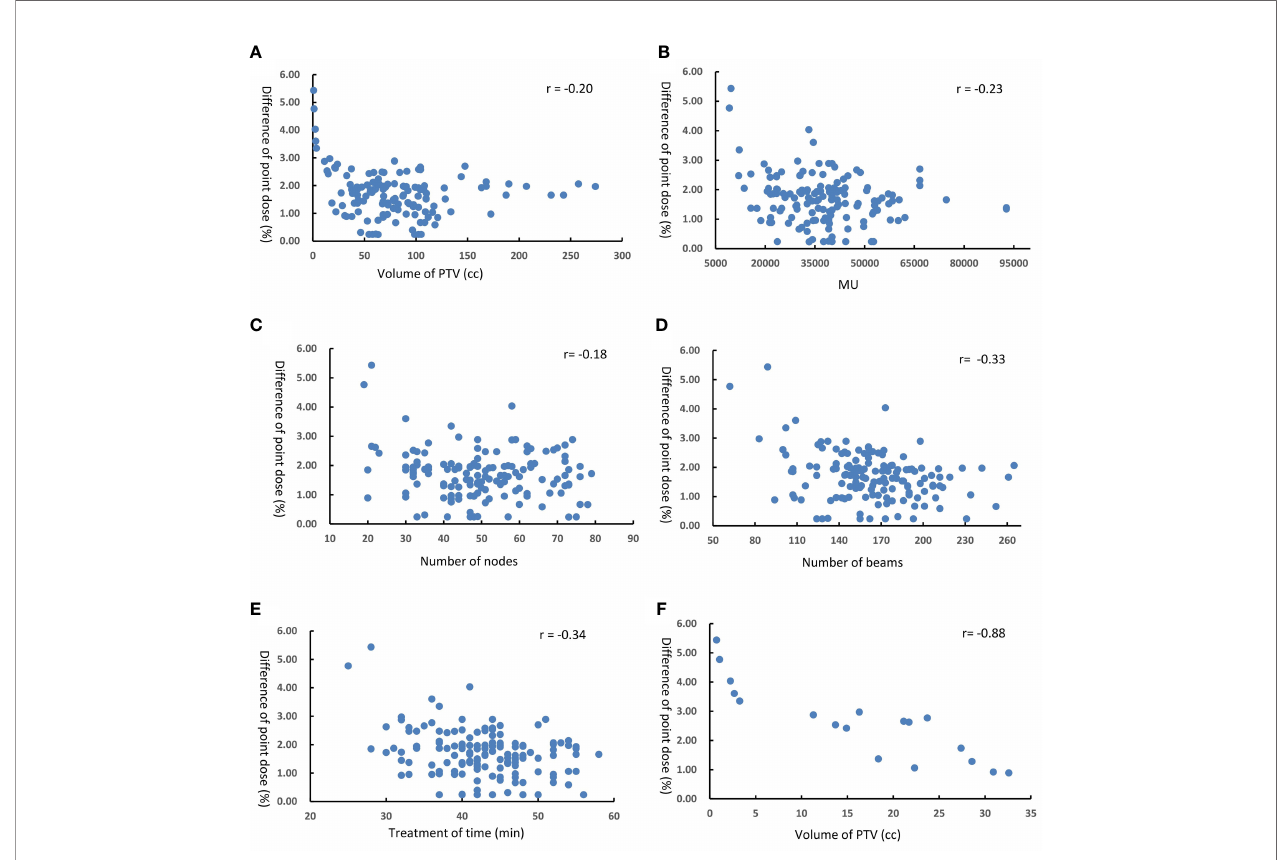
FIGURE 4 | Difference of point dose as function of (A) volume of PTV (B) MU (C) number of nodes (D) number of beams (E) treatment time in 150 DQA plans, and (F) volume of PTV in 18 DQA